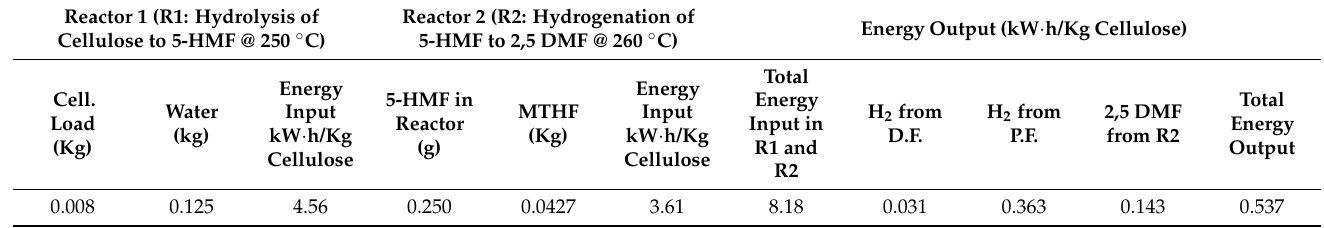
Table 4. The energy balance of this work consisting of the energy input for the cellulose hydrolysis and hydrogenation reactions compared to the energy output obtained from the bio-H 2 yields of dark and photo-fermentation and 2,5 DMF obtained from the hydrogenation reaction. Dark Fermentation (D.F.); Photo-fermentation (P.F.). All calculations in this table were based on average values from experiments as described in this